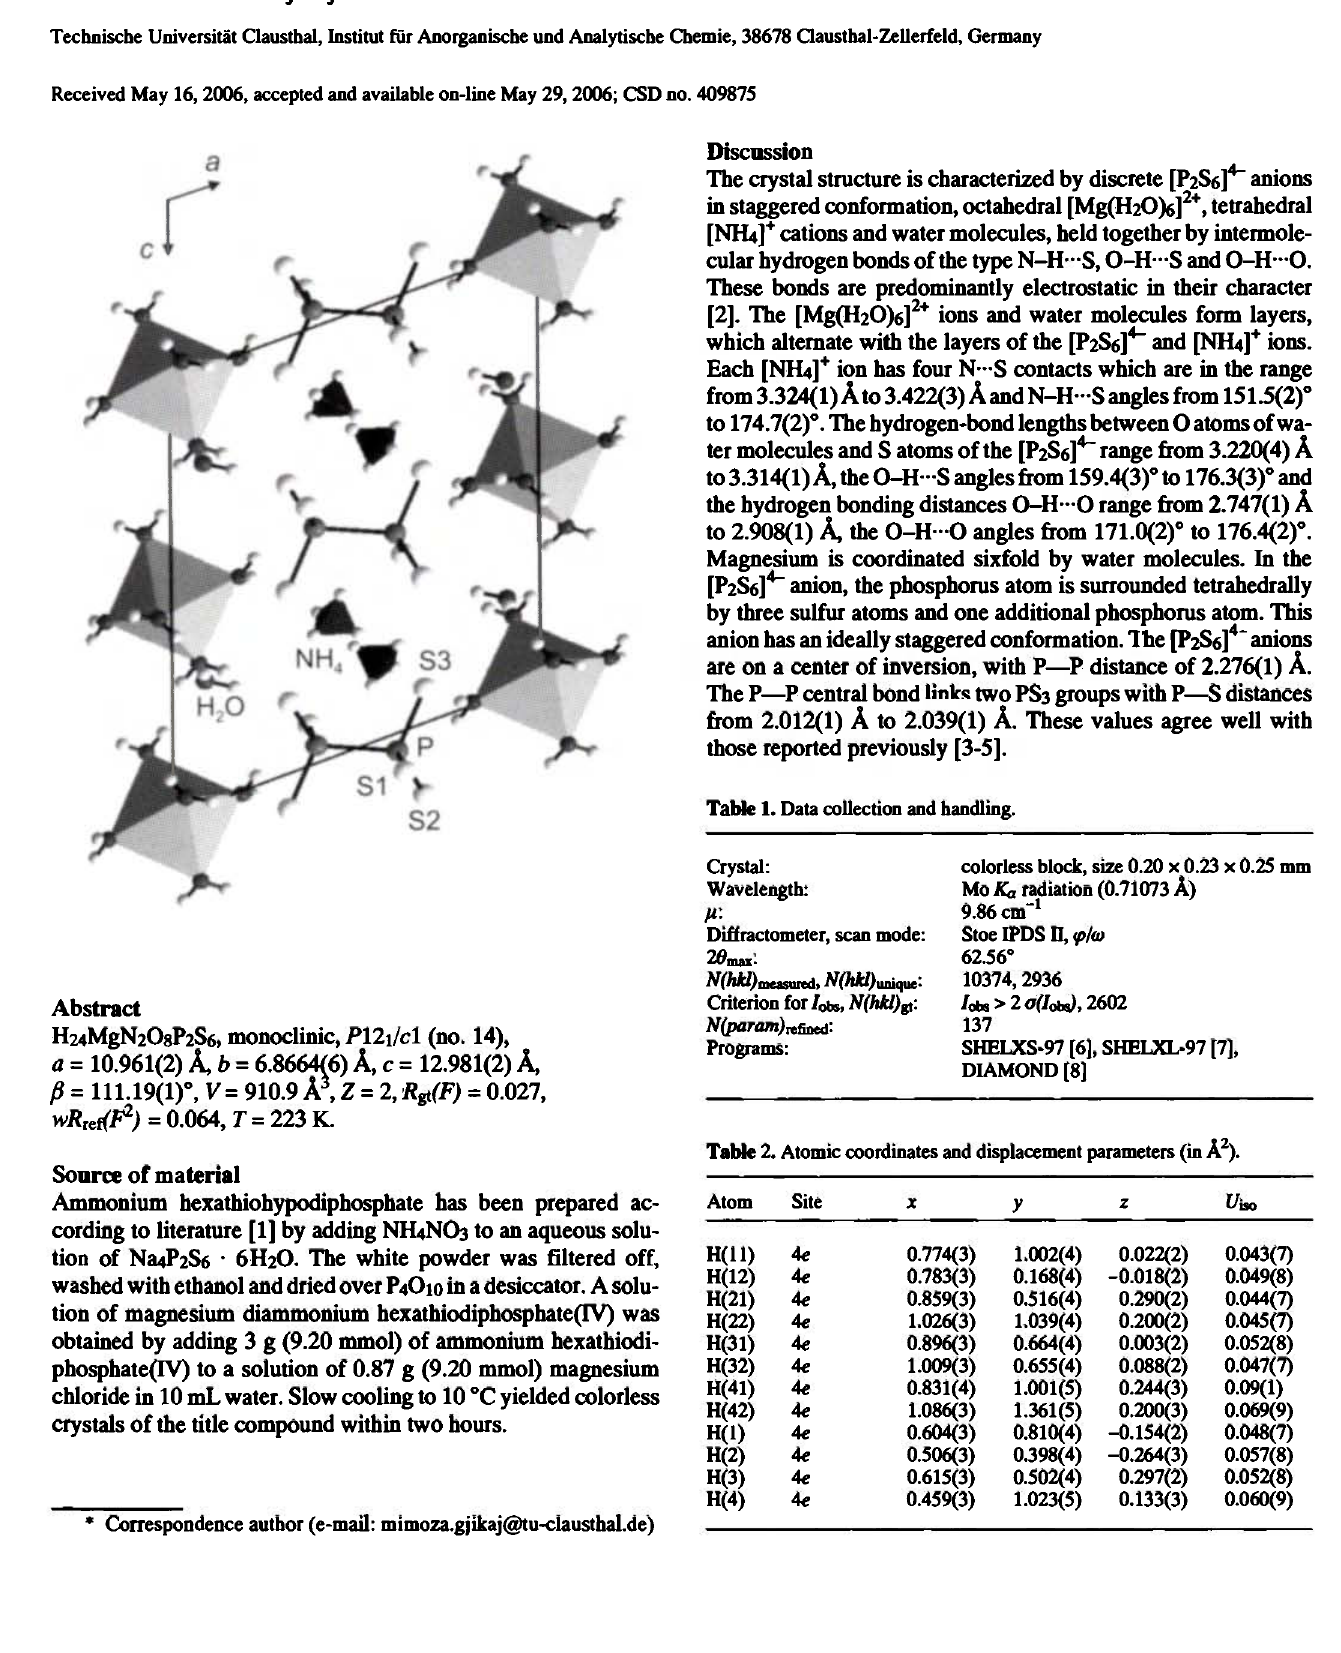
Table 2. Atomic coordinates and displacement parameters (in A 2